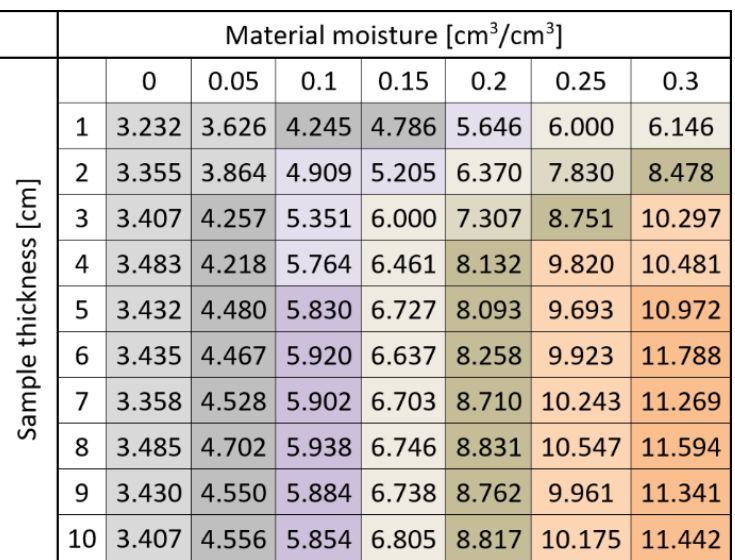
12 of 16 Figure 10. Post hoc analysis of apparent permittivity readouts using sensor A for various values of sample moistures and sample thicknesses. Each color means different homogenous group. In the case of sensor B, the ANOVA suggests the following: • The main effect of moisture is statistically significant and large (F(6, 140) = 3196.57, p < 0.001; 𝜂 𝑝2 = 0.99, 90% CI (0.99, 0.99)); • The main effect of thickness is statistically significant and large (F(9, 140) = 241.16, p < 0.001; 𝜂 𝑝2 = 0.94, 90% CI (0.93, 0.95)); • The interaction between moisture and thickness is statistically significant and large (F(54, 140) = 18.71, p < 0.001; 𝜂 𝑝 2 = 0.88, 90% CI (0.84, 0.89)). Similarly, as for sensor A, the fact that in each case, 𝜂 𝑝2 is much greater than 0.14 — which means that the effect is very large — should be noted. Moreover, this fact is con- firmed by narrow confidence intervals. These effects are even larger than in the case of